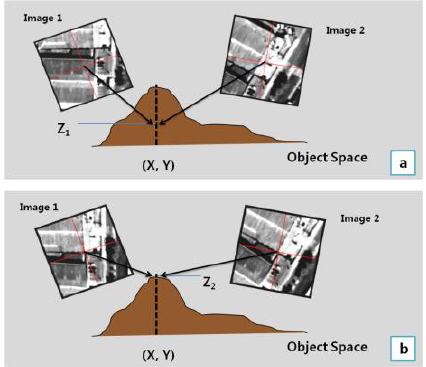
Figure 7. Object space-based matching with multi- dimensional search window (5 windows and 5